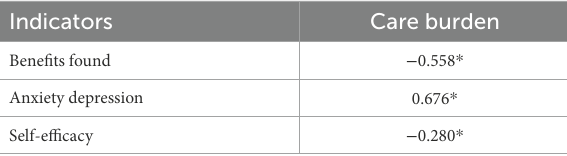
TABLE 3 Correlation analysis of care burden of caregivers of pancreatic cancer patients and its influencing factors (R value). Indicators Care burden